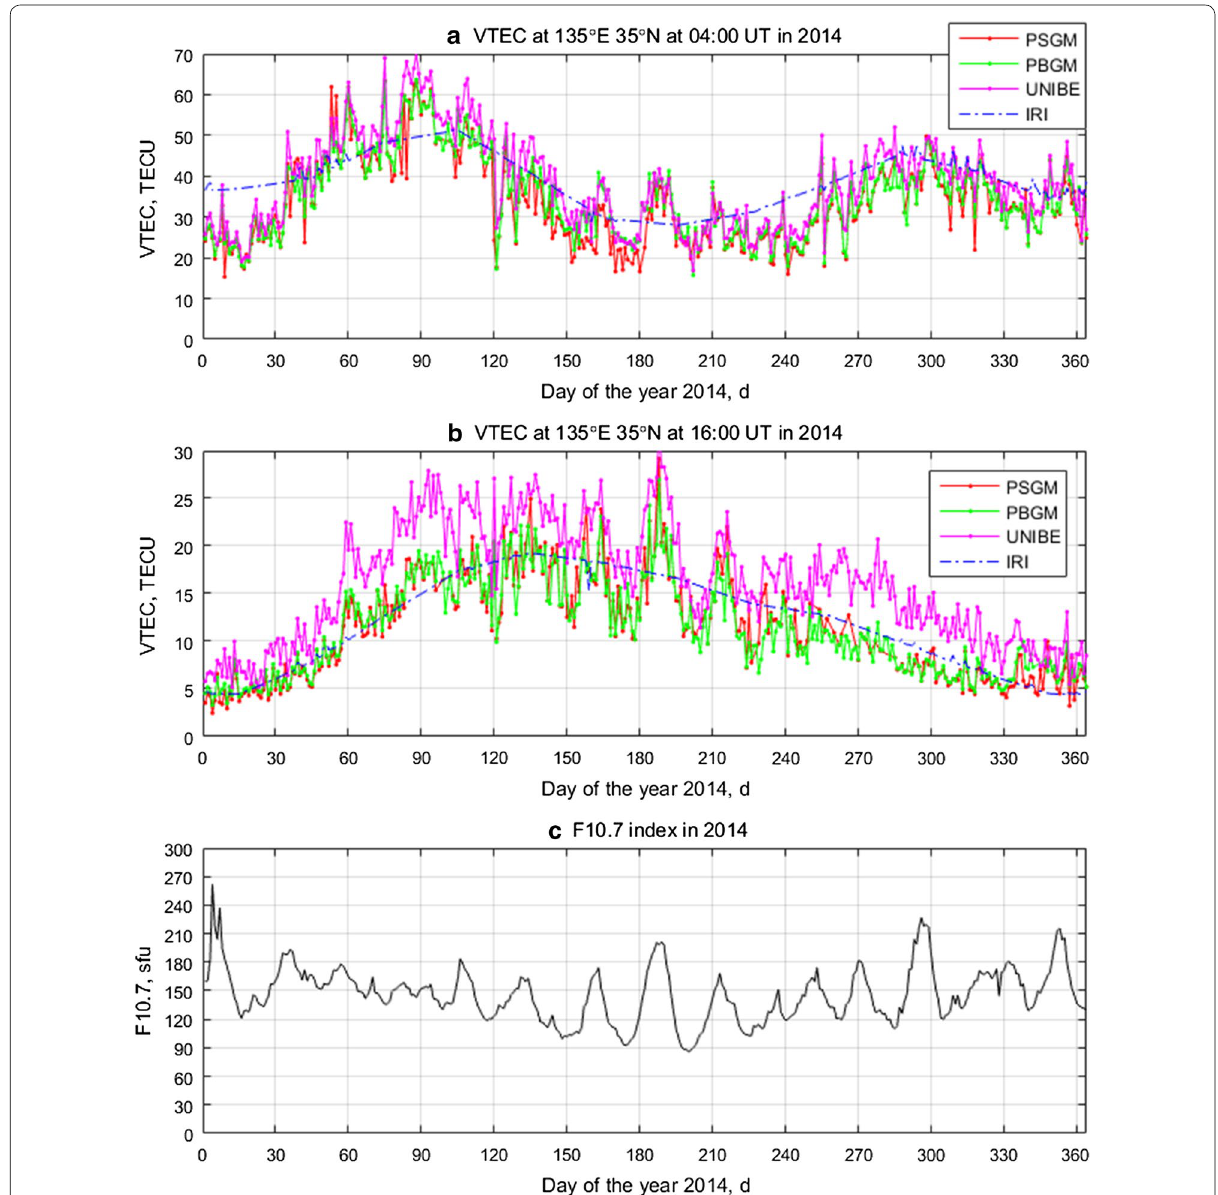
Fig. 3 VTEC seasonal variation of 2014 at 135°E 35°N. a 04:00 UT; b 16:00 UT; c F10.7